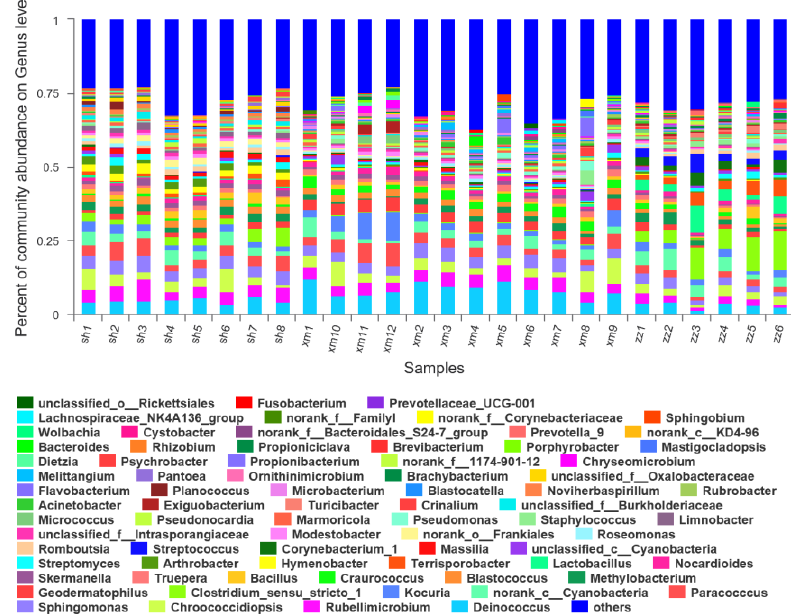
Figure 8. Composition diagram of the bacterial community of 26 samples at genus level. (sh: Shanghai; xm: Xiamen; zz: Zhangzhou; the abundance of a group less than 0.01% was merged into other groups).